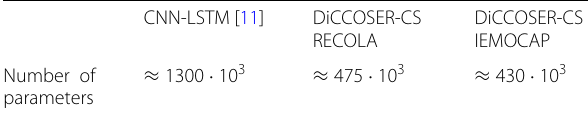
Table 3 Summary of the number of model